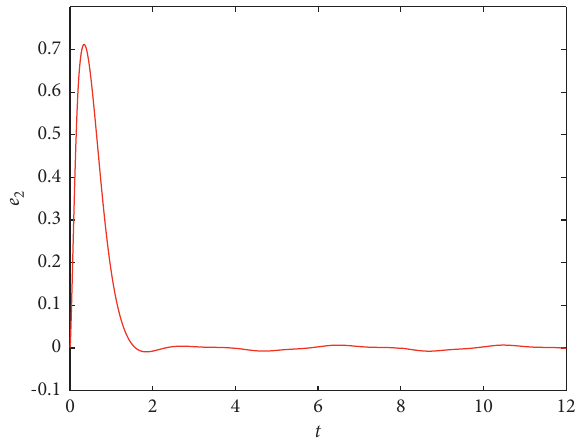
Figure 10: State error e